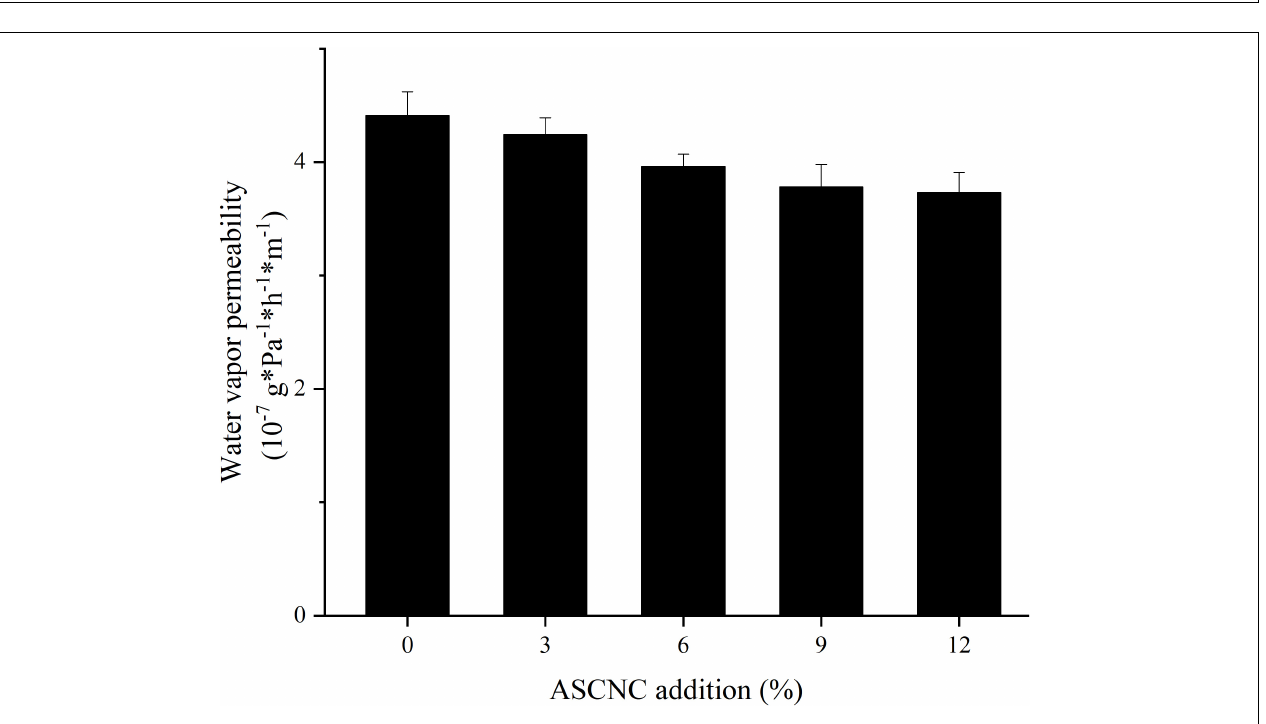
films decreased from 143 to 79% with increasing amounts of ASCNC up to 9% ( Figure 4B ), which was a result of physical entanglement and hydrogen bonding between CNC and